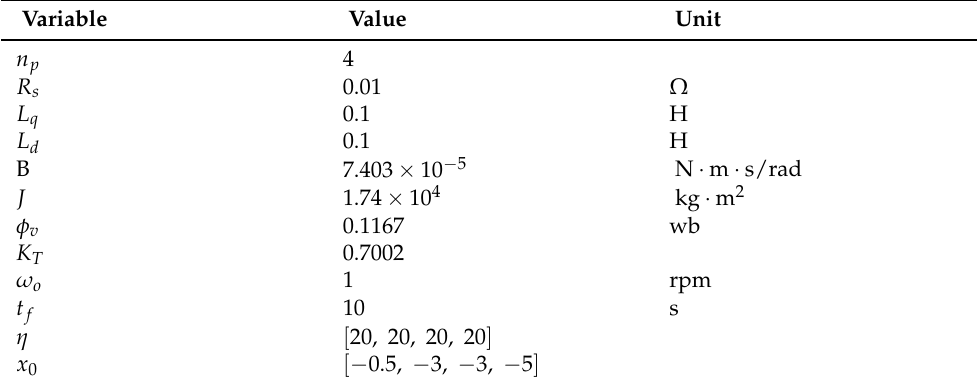
Table 1. PMSM parameter values.